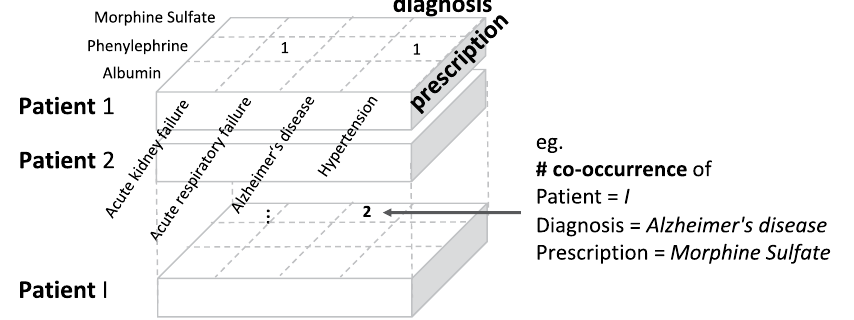
Figure 2. Constructing tensor from EHRs. We built a third-order tensor  with co-occurrences of patients, diagnoses, and prescriptions from EHRs. Patient I is diagnosed with Alzheimer ’ s disease and is ordered morphine sulfate